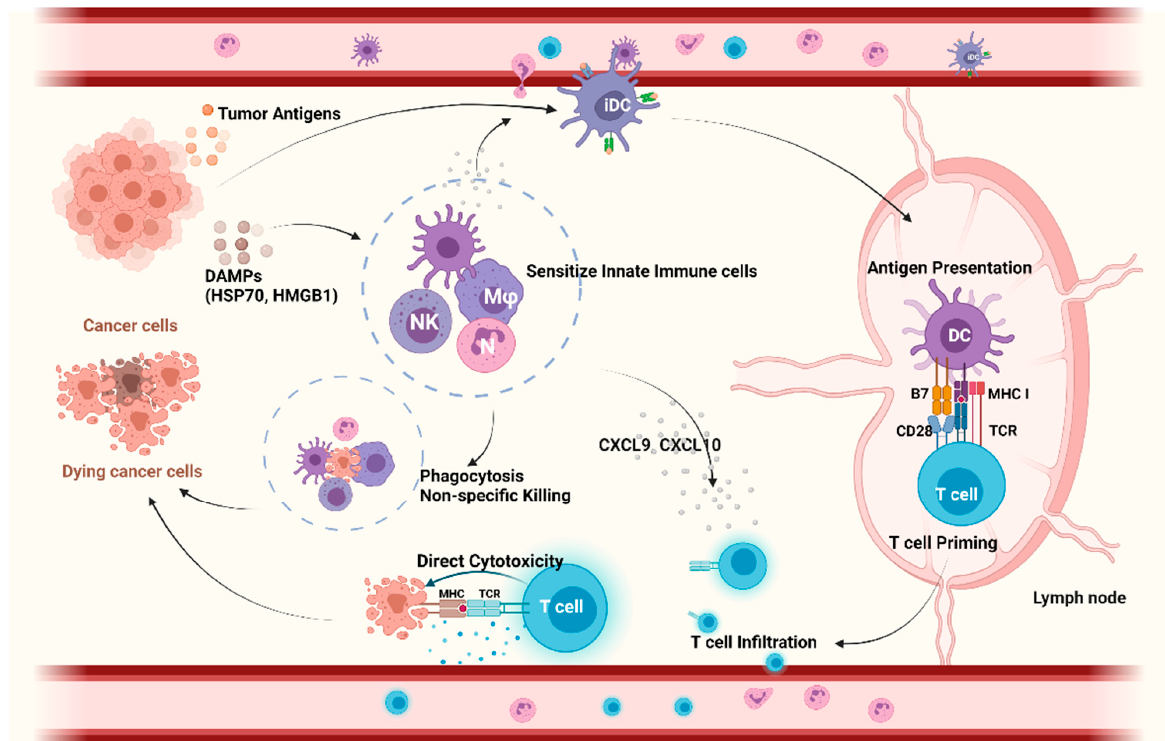
Figure 1. The role of innate immunity in anticancer response. Within the tumor immunity cycle, myeloid cells (NK cells, M φ ) recognize tumor cells via DAMPs and exert direct cytolysis by which they activate an adaptive immune response and recruit DCs into the TME. DCs take up and process tumor antigens and migrate to lymph nodes to cross-present the tumor antigens to CD8+ T cells, resulting in their activation. In addition, DCs produce chemokines to recruit tumor-specific CD8 T cells into TME, exerting direct cytotoxicity on tumor cells. Collectively, innate immune cells are closely involved in antitumor response via non-specific killing and modulation of tumor-specific T cell priming, infiltration, and cytotoxicity. Abbreviations: APC, antigen presenting cells; CXCL, Chemokine (C-X-C motif) ligand 9; DAMPs, damage-associated mo- lecular pattern; DCs, dendritic cells; HMGB1, high mobility group box 1 protein; HSP70, 70 kilodalton heat shock proteins;